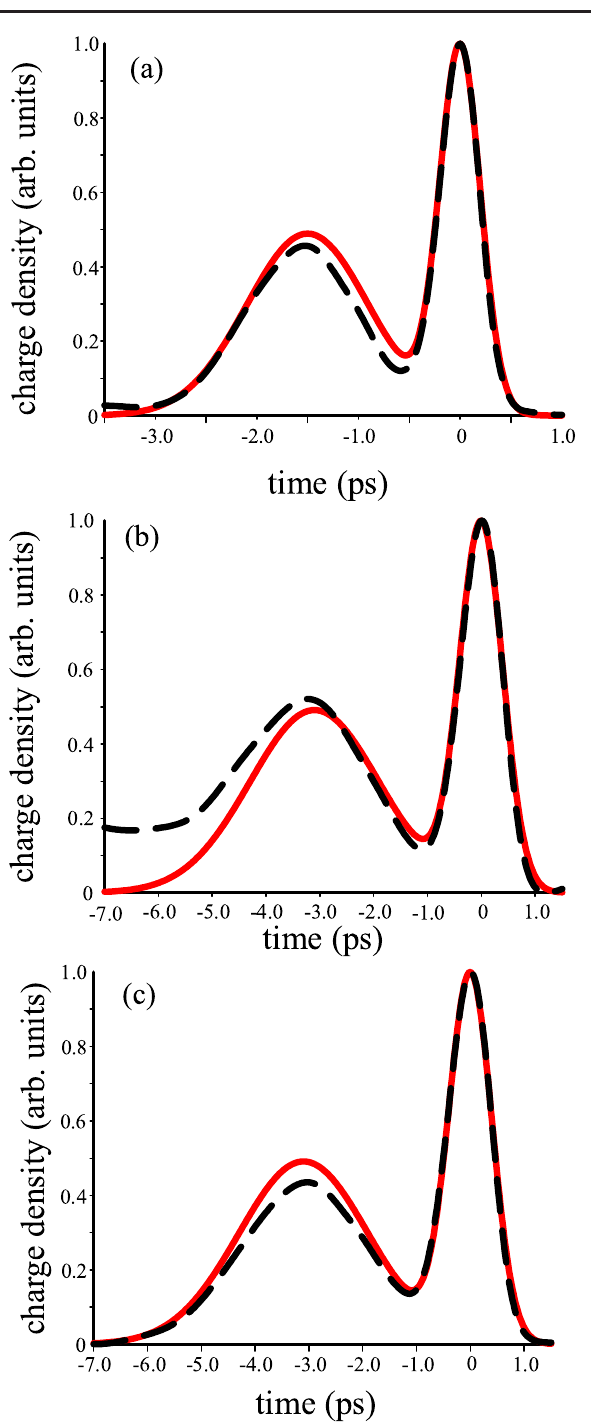
FIG. 7. (Color) Demonstration of the accuracy of the KK recon- struction of an asymmetric bunch profile, using the expected output from three different gratings. In all cases the original bunch consists of a superposition of two